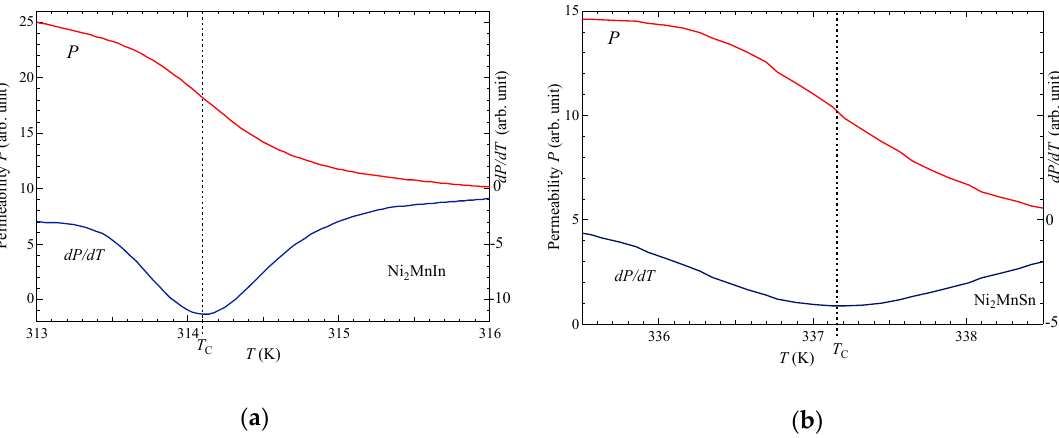
Figure 2. Permeability ( P ) and dP / dT (di ff erential of the permeability in the temperature) of ( a ) Ni 2 MnIn and ( b ) Ni 2 MnSn around T C . The dotted lines define T C .